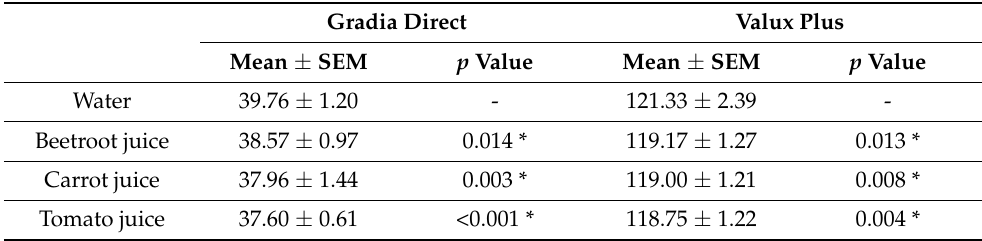
Table 2. HV microhardness (Mean ± Standard Error of Mean) of Gradia Direct and Valux Plus samples after seven days of immersion in test media.